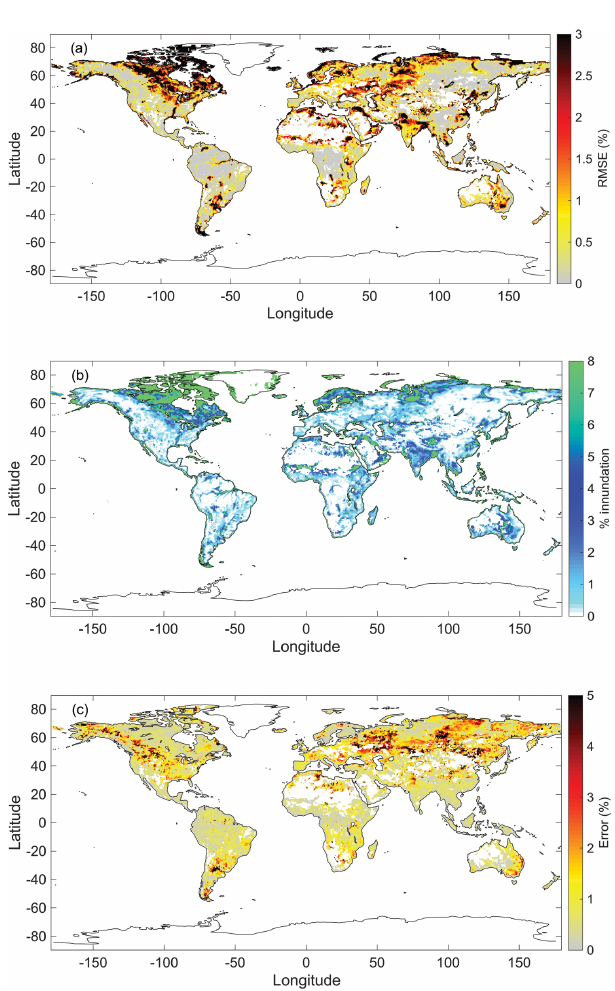
Figure 8. (a) RMSE between modeled and measured SWAMPS data with a time lag correction of 0 to 5 months. (b) Long-term av- erage (LTA) surface inundation. (c) Error relative to the measured SWAMPS signal.